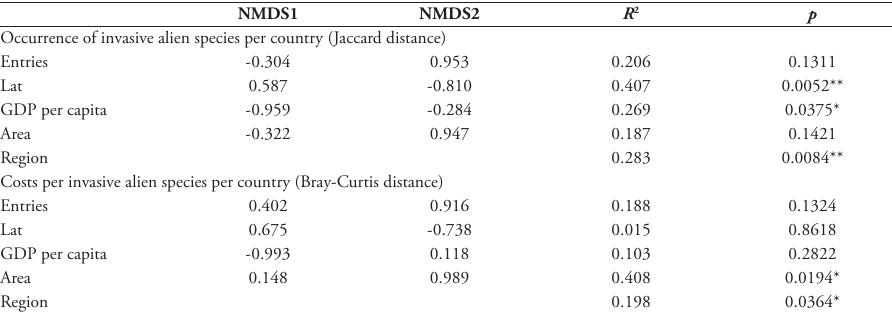
Table 2. Model fitting of geographical and socioeconomic variables in the ordinations, based on occur- rence of alien species and costs per alien species in Central and South America. Number of permutations = 10000. NMDS1 NMDS2 R 2 p Occurrence of invasive alien species per country (Jaccard